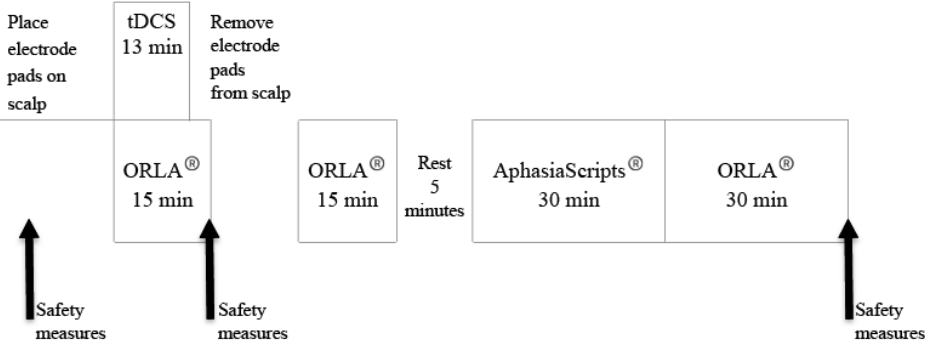
Figure 5. Schematic of a daily treatment session showing the sequence and length of time of each of the behavioral treatments: Oral Reading for Language in Aphasia (ORLA ® ️ ) and AphasiaScripts ® ️ . The tDCS was always applied with ORLA ® ️ . The schematic also shows when safety measures were collected.